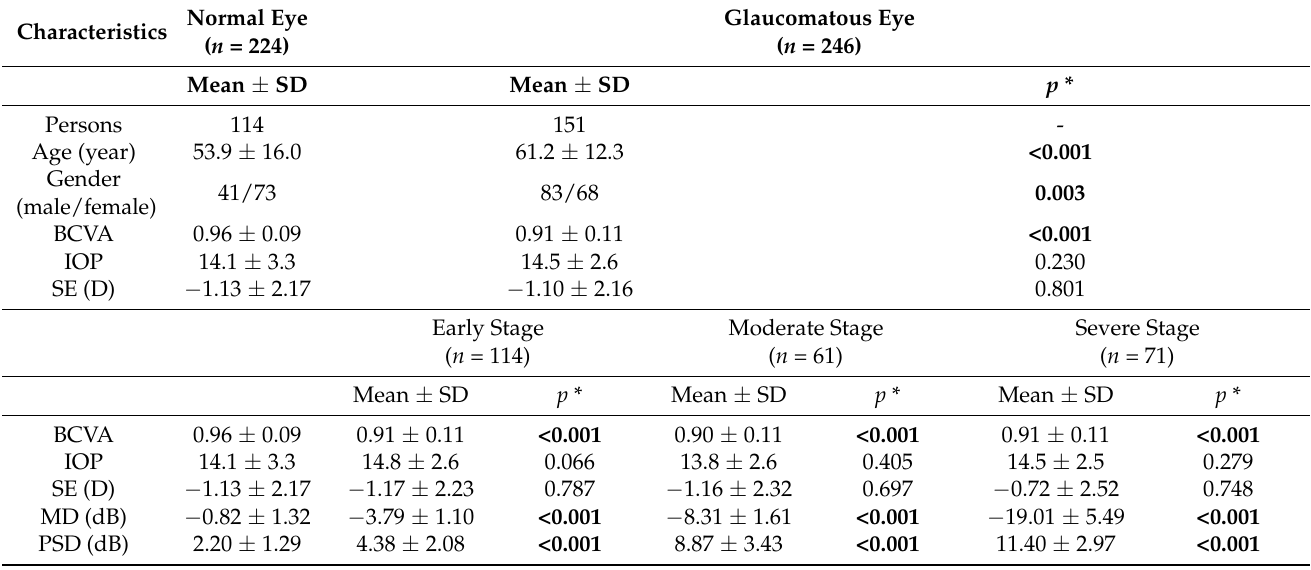
Table 1. Demographics and clinical characteristics of the study